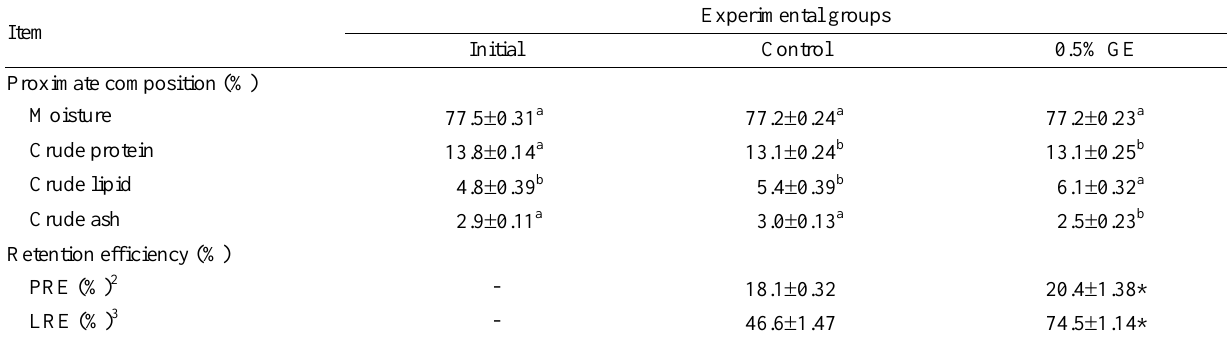
Table 3. Proximate composition (%, as-is basis) of whole body and protein and lipid retention efficiencies of juvenile sterlet sturgeon fed diets with or without garlic extracts (GE) for 5 wk